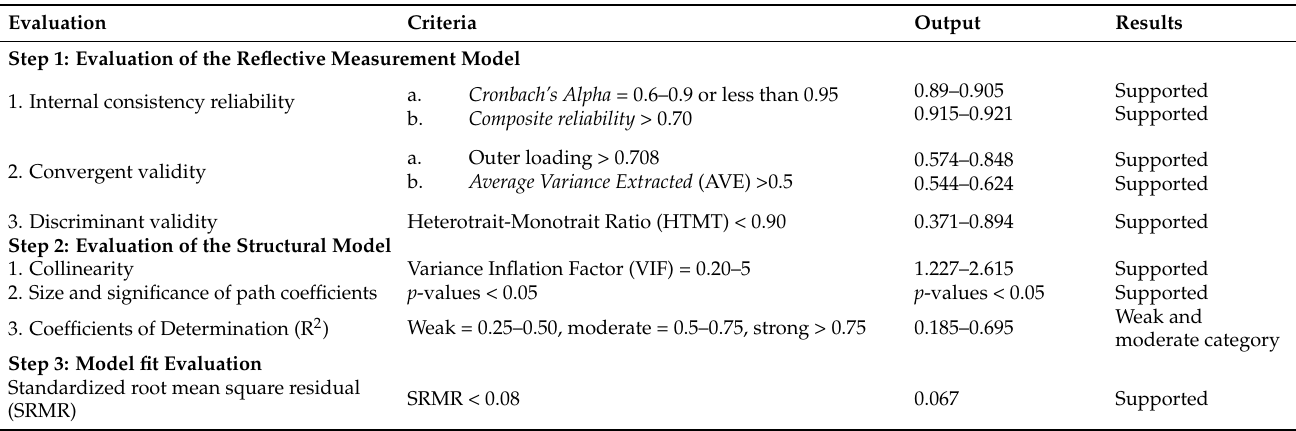
Table 1. Summary of PLS-SEM